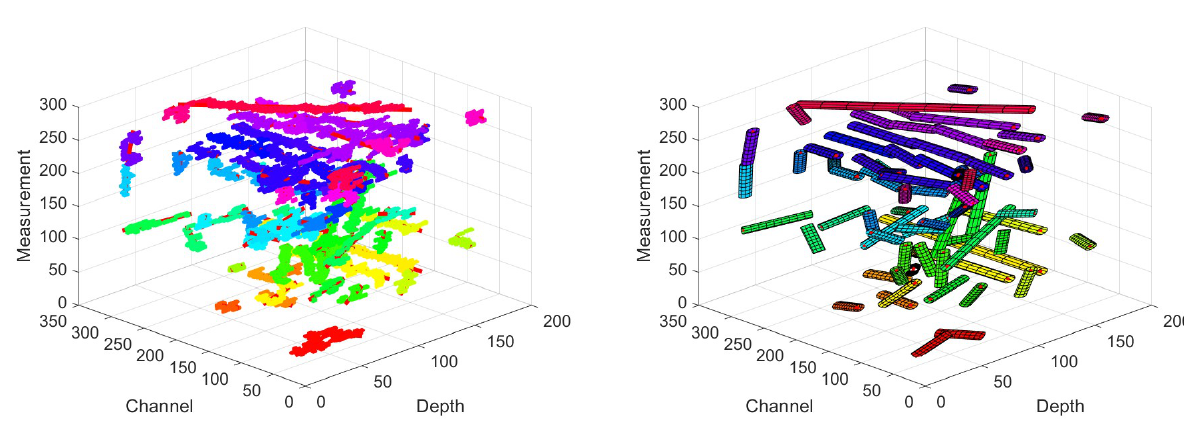
Figure 14 . Approximation of point cloud clusters by lines. Figure 15 . Visualization of detected pipes.